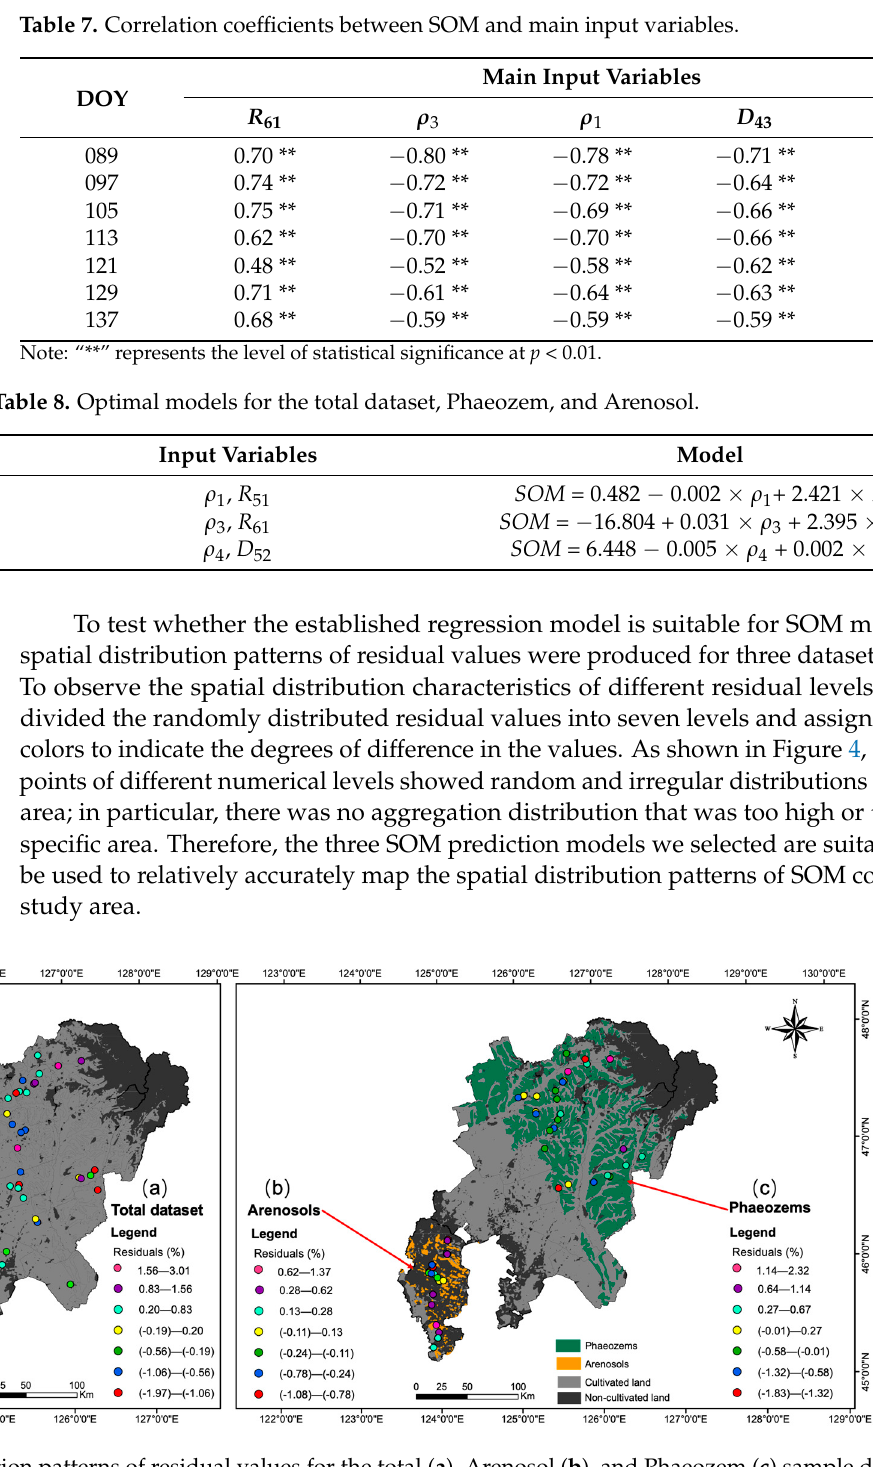
Figure 4. Spatial distribution patterns of residual values for the total ( a ), Arenosol ( b ), and Phaeozem ( c ) sample datasets .